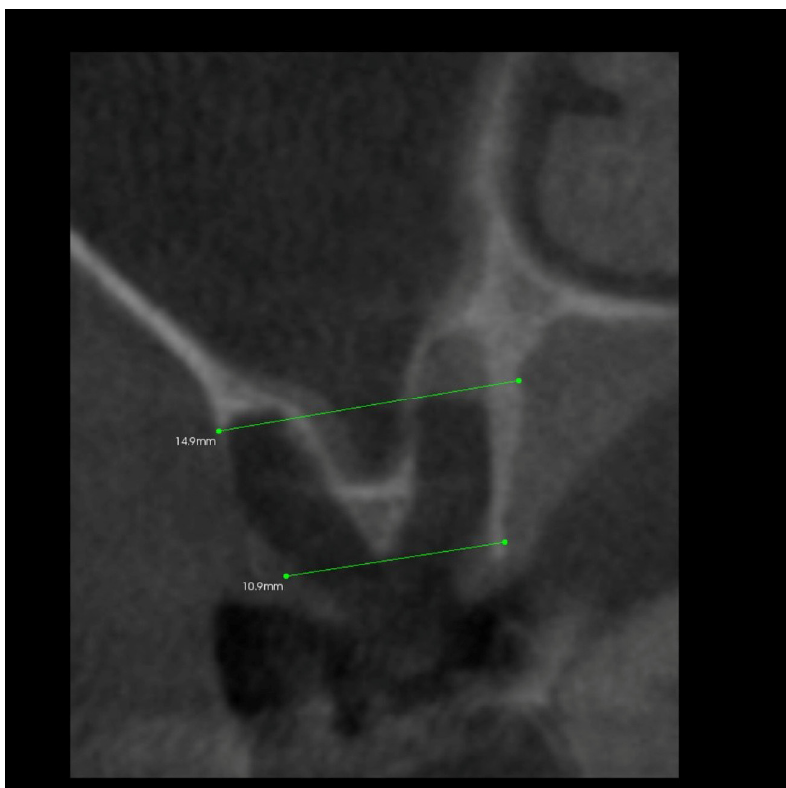
Figure 5. Transverse imaging of maxillary alveolus obtained from CBCT. The alveolus width measurement 10 days post-extraction.